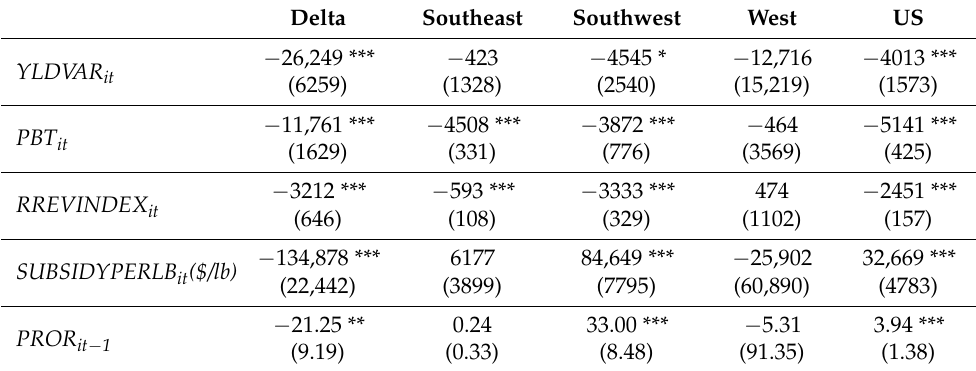
Table 4. US and regional county planted acreage response estimates (acres).